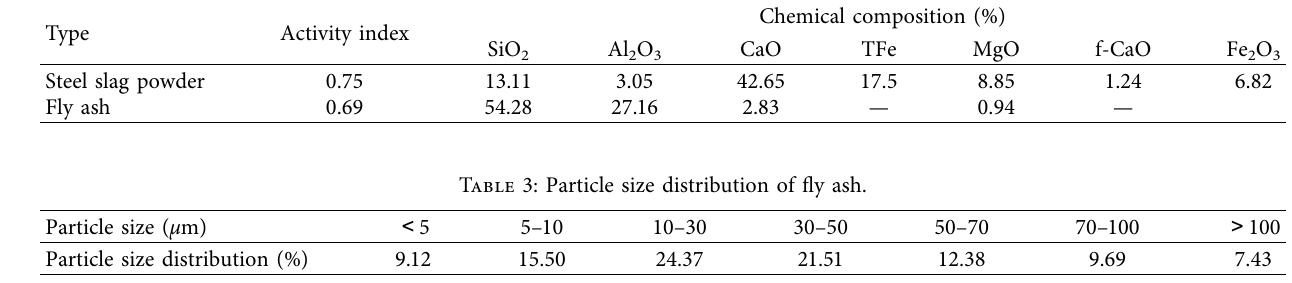
Table 2: Main performance indicators of mineral admixture micronized